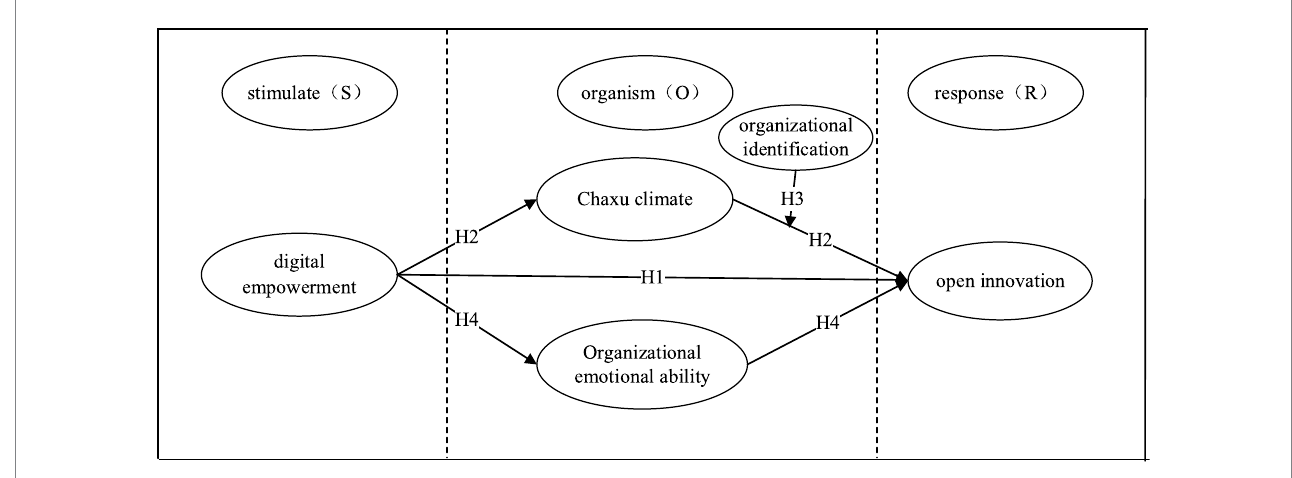
FIGURE 2 Open innovation performance impact mechanism